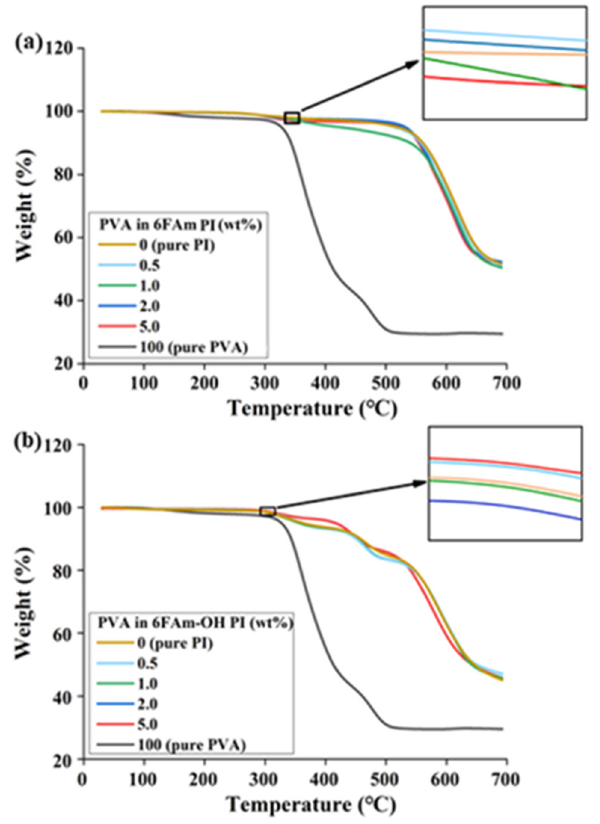
Figure 4. TGA thermograms of CPI membrane films with various PVA contents: ( a ) 6FAm PI and ( b ) 6FAm-OH